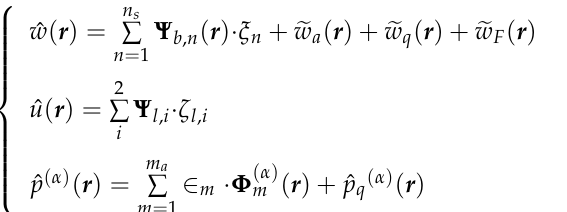
where c is the sound speed inside the acoustic cavity, and k is the acoustic wave number. According to the basic concept of the WBM, both the structural displacement and sound pressure can be approximated by a summation of the specific wave functions